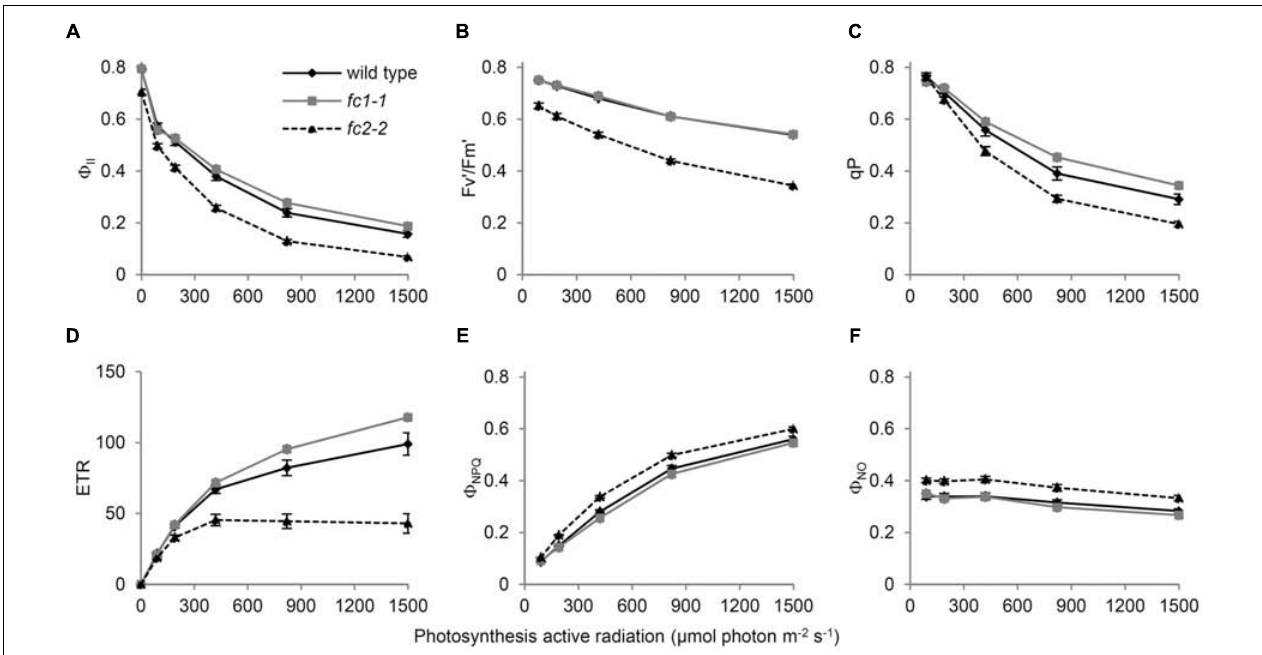
FIGURE 6 | Chlorophyll fluorescence parameters of wild-type and ferrochelatase deficient mutants. Light response curves of (A) (cid:56) II , (B) F v (cid:48) /F m (cid:48) , (C) qP, (D) ETR, (E) (cid:56) NPQ , and (F) (cid:56) NO are shown. (cid:56) II , PSII quantum yield/operating quantum efficiency of PSII photochemistry; F v (cid:48) /F m (cid:48) , efficiency of open PSII reaction centers; qP, fractions of PSII centers in open states based on puddle model for the photosynthetic unit; ETR, electron transfer rate in PSII; (cid:56) NPQ , quantum yield of light-induced non-photochemical quenching (NPQ)/NPQ efficiency; (cid:56) NO , non-regulated energy dissipation. PAR means photosynthetic active radiation. Bar indicates SEM from five independent experiments for wild type and fc2-2 . In addition, two biological replicates of the fc1-1 data were included as